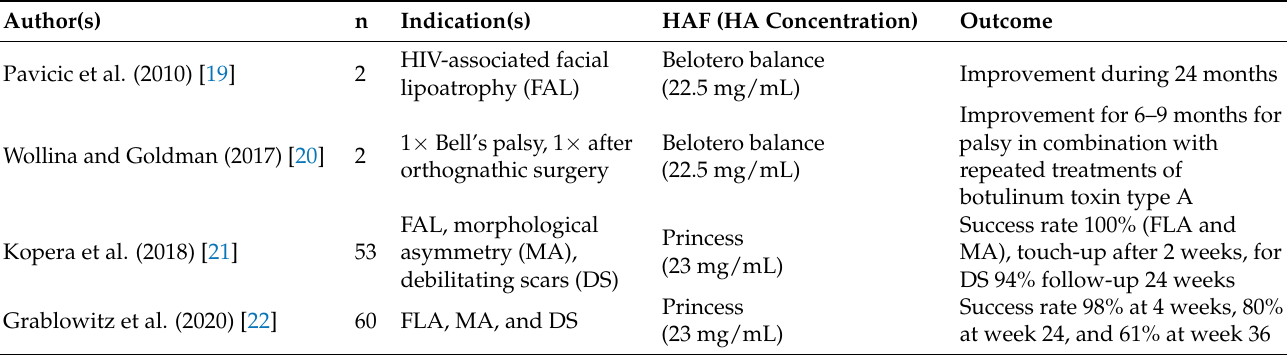
Table 2. Use of HAF in facial asymmetry (n—patient